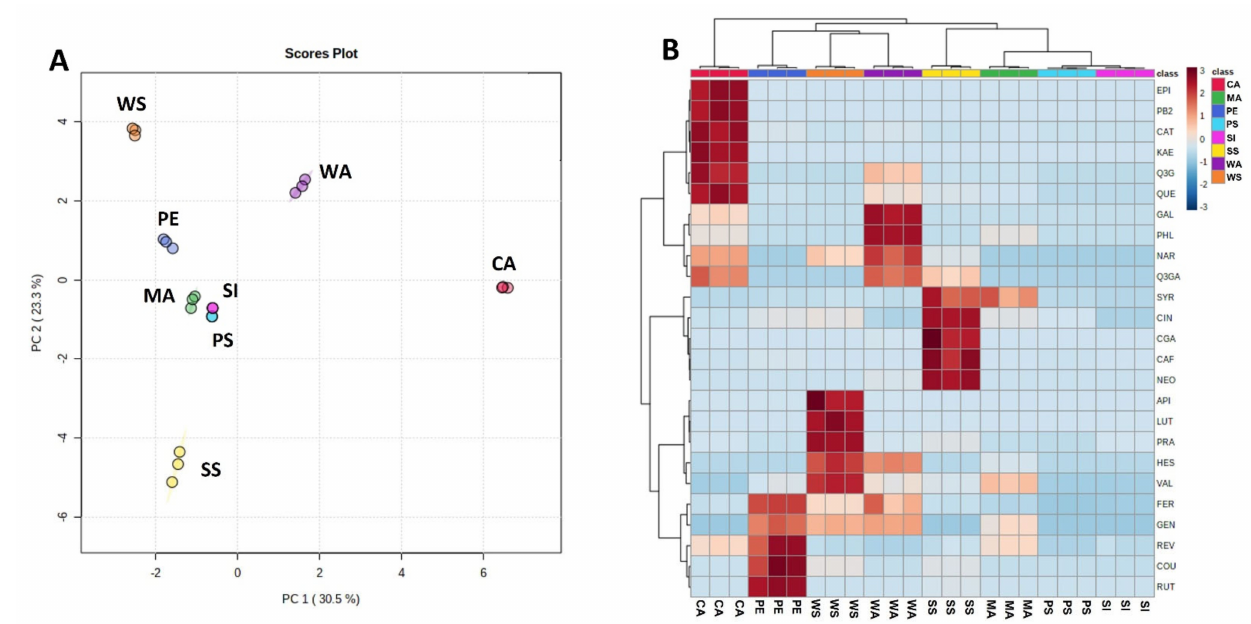
Figure 2. Principal component analysis ( A ) and heatmap ( B ) of phenolic data of the studied nuts and seeds. Abbreviations: CA (cashew), MA (macadamia), PE (peanut), SI (sacha inchi), WA (walnut), PS (pumpkin seed), SS (sunflower seed), WS (watermelon seed).